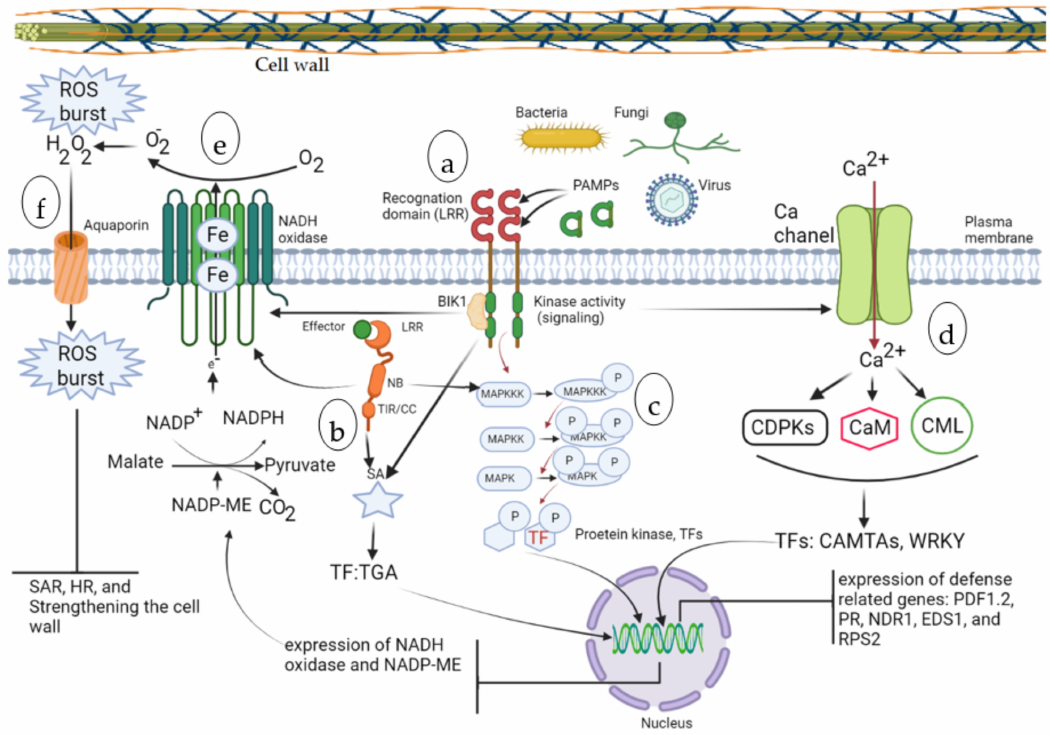
Figure 1. Schematic representation of pathogen perception, different signaling pathways, and cor- responding defense responses in trees. ( a ) pattern recognition receptors (PRRs), ( b ) nucleotide binding site-leucine-rich repeats (NBS-LRR) family of receptors, ( c ) mitogen-activated protein ki- nase (MAPK) cascade, ( d ) turbulence in calcium concentration during stress and its perception by several proteins, ( e ) activation of NADH oxidase and production of reactive oxygen species (ROS), ( f ) transport of hydrogen peroxide through an aquaporin